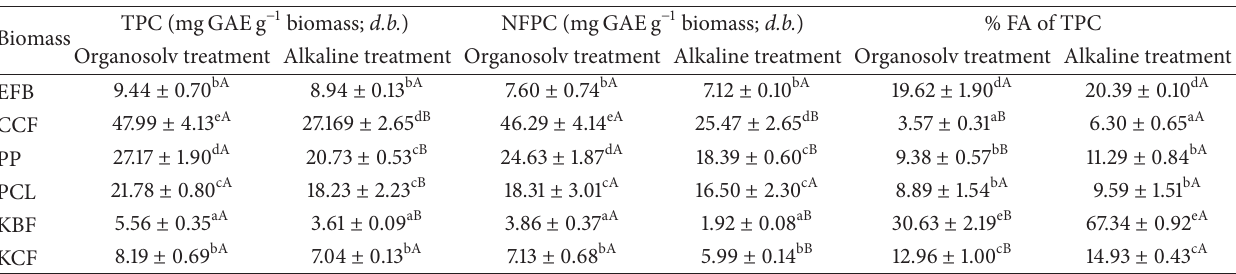
Table 4: Total nonferulate phenolic compounds (NFPC) and percentage of ferulic acid (FA) content in total phenolic compounds (TPC) in lignin-free liquor produced from six different biomasses through alkaline and organosolv treatment at 120 ∘ C for an hour ( 𝑛 = 3 ; 𝑃 < 0.05 ). TPC (mgGAE g − 1 biomass; d.b. ) NFPC (mgGAE g − 1 biomass; d.b. Biomass